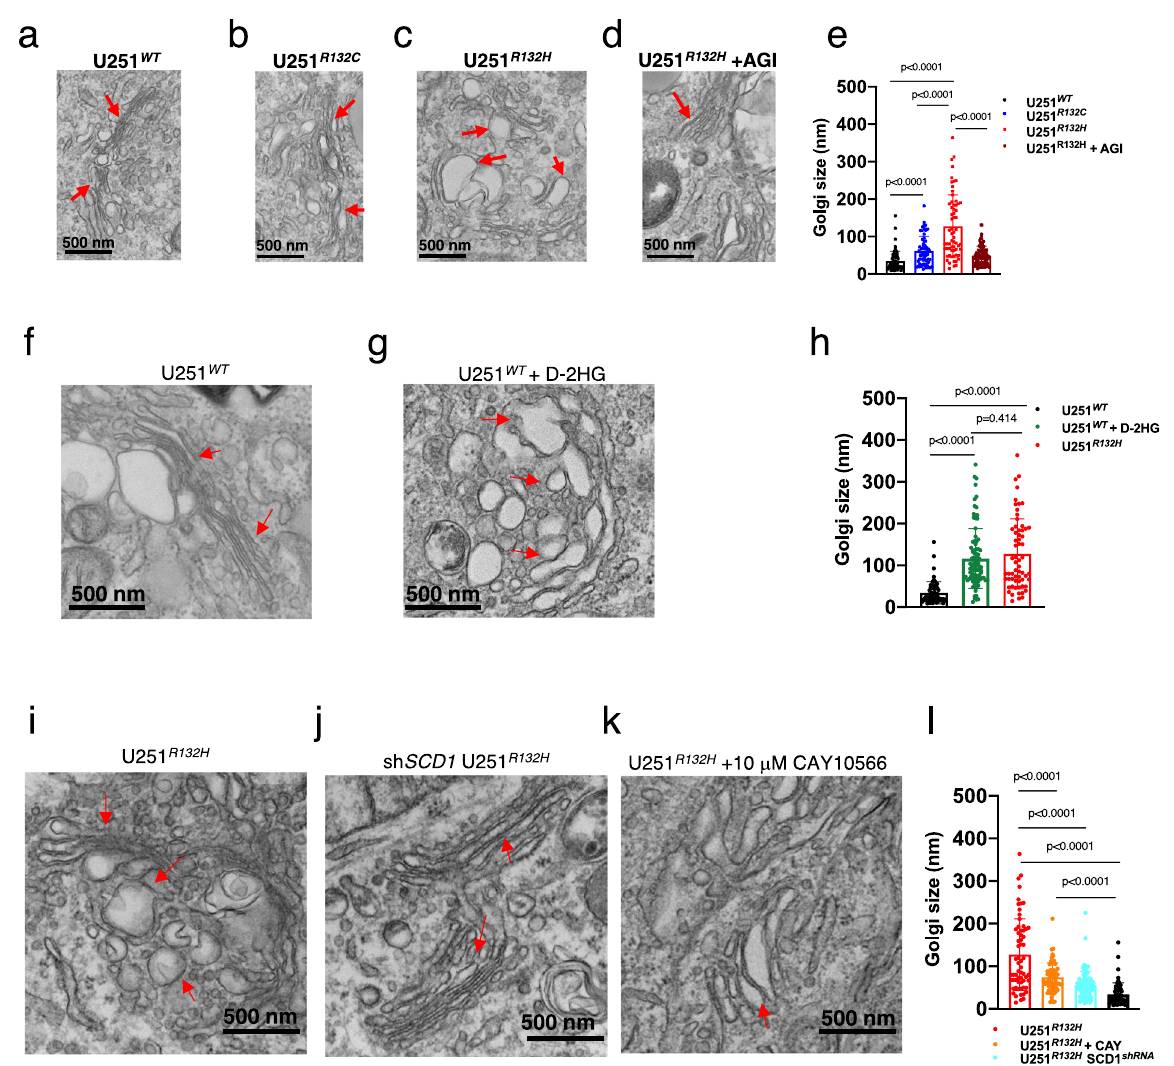
Fig. 4 D-2HG levels and SCD expression are responsible for IDH1 mut -induced membrane defects in Golgi. a – d Transmission electron micrographs of U251 WT , U251 R132C U251 R132H , and U251 R132H + AGI5198 show signi fi cant changes in the Golgi structure. Arrows indicate the altered region of Golgi stacks. e Golgi size quanti fi cation of U251 WT ( n = 63, black symbols), U251 R132C ( n = 59, blue symbols), U251 R132H ( n = 63, red symbols), and U251 R132H + AGI5198 ( n = 90, dark red symbols). Statistical values are represented on the graph. f , g Addition of D-2HG in U251 WT was enough to cause Golgi dilation. h Golgi size quanti fi cation of U251 WT ( n = 63, black symbols), U251 WT + D-2HG ( n = 90, green symbols), and U251 R132H ( n = 63, red symbols). i – j Comparison between Golgi of U251 R132H cells and the U251 R132H cells that lack hSCD showed a restored Golgi structure. k Inhibiting the hSCD enzyme with CAY10566 led to partial restoration of Golgi structure. l Golgi size quanti fi cation of U251 R132H ( n = 63, red symbols), U251 R132H + CAY10566 ( n = 69, orange symbols), and siRNA hSCD U251 R132H ( n = 84, cyan symbols). For e , h , l the mean values and SD are presented and the p values obtained from a one-way ANOVA tests with Tukey ’ s correction for multiple comparisons were conducted using GraphPad Prism 8.2.1. At least 10 images per organelles were taken. Data are available in Source Data fi le. Micrographs are representative of three independent